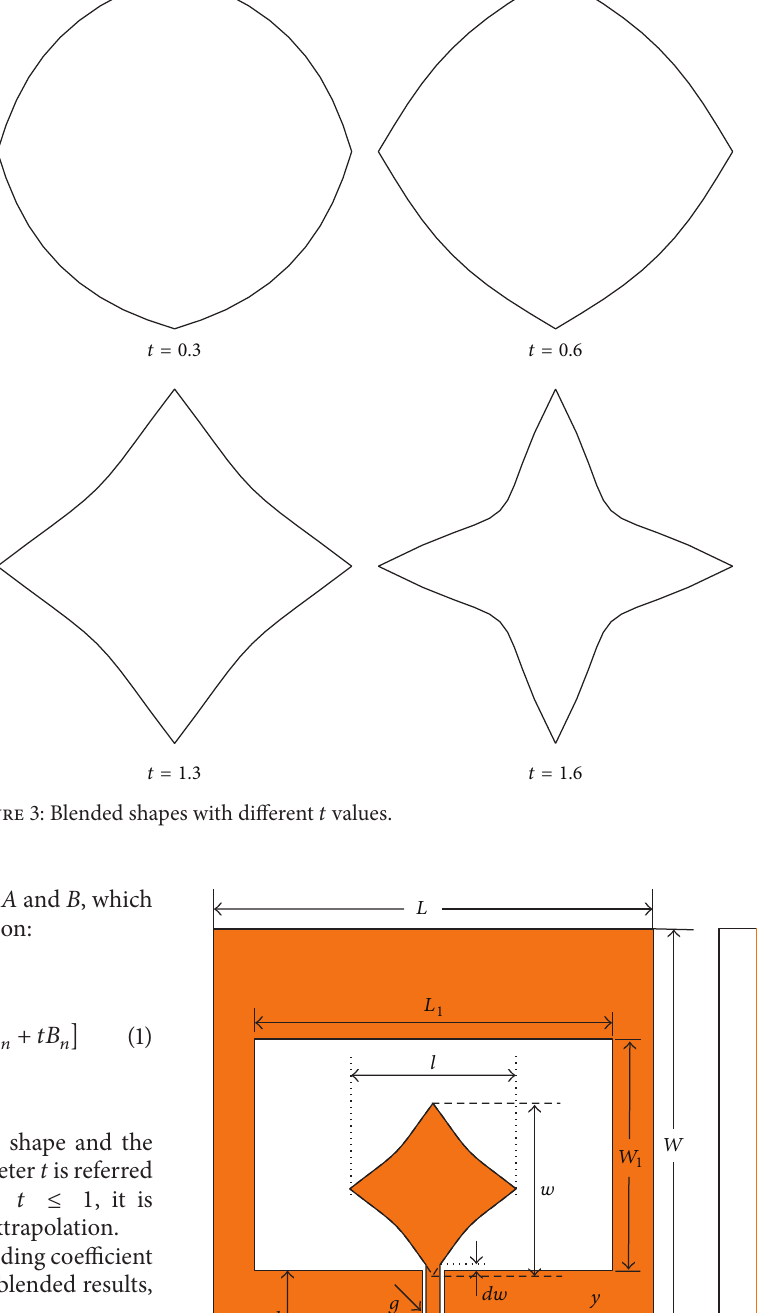
connected to a CPW feed line with its length of d and